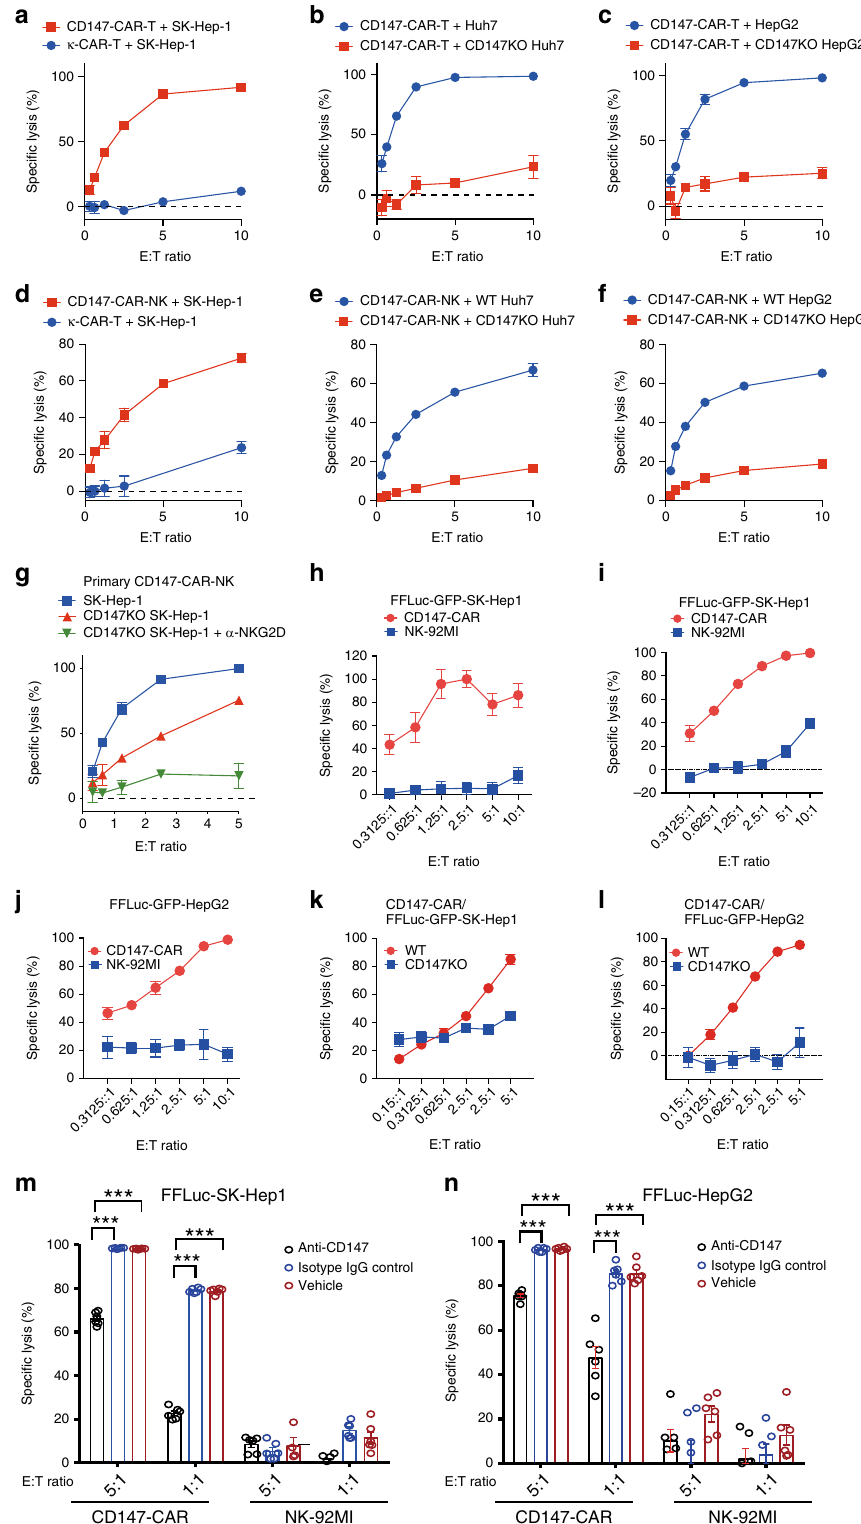
decreased (Supplementary Fig. 9C), which further validated the speci fi c cytotoxicity of CD147-CAR-T cells against CD147 + HCC cell lines. Together, the data indicate that CD147-CAR-modi fi ed immune cells, including primary T and NK cells, as well as NK- 92MI cells, can kill CD147 + target cells, selectively and speci fi